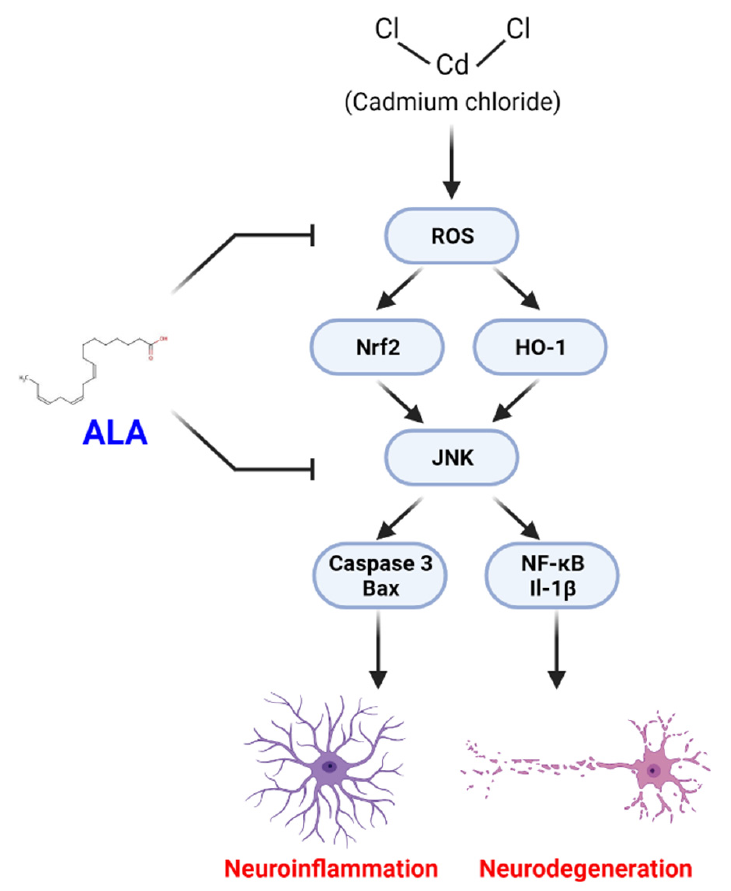
Figure 6. Proposed neuroprotective mechanism of ALA against Cd-induced neurodegeneration. The mechanism reveals that ALA treatment attenuates Cd-induced generation of ROS leading to suppression of Nrf2, OH-1 antioxidant system, neuroinflammation, and neurodegeneration in the adult mouse